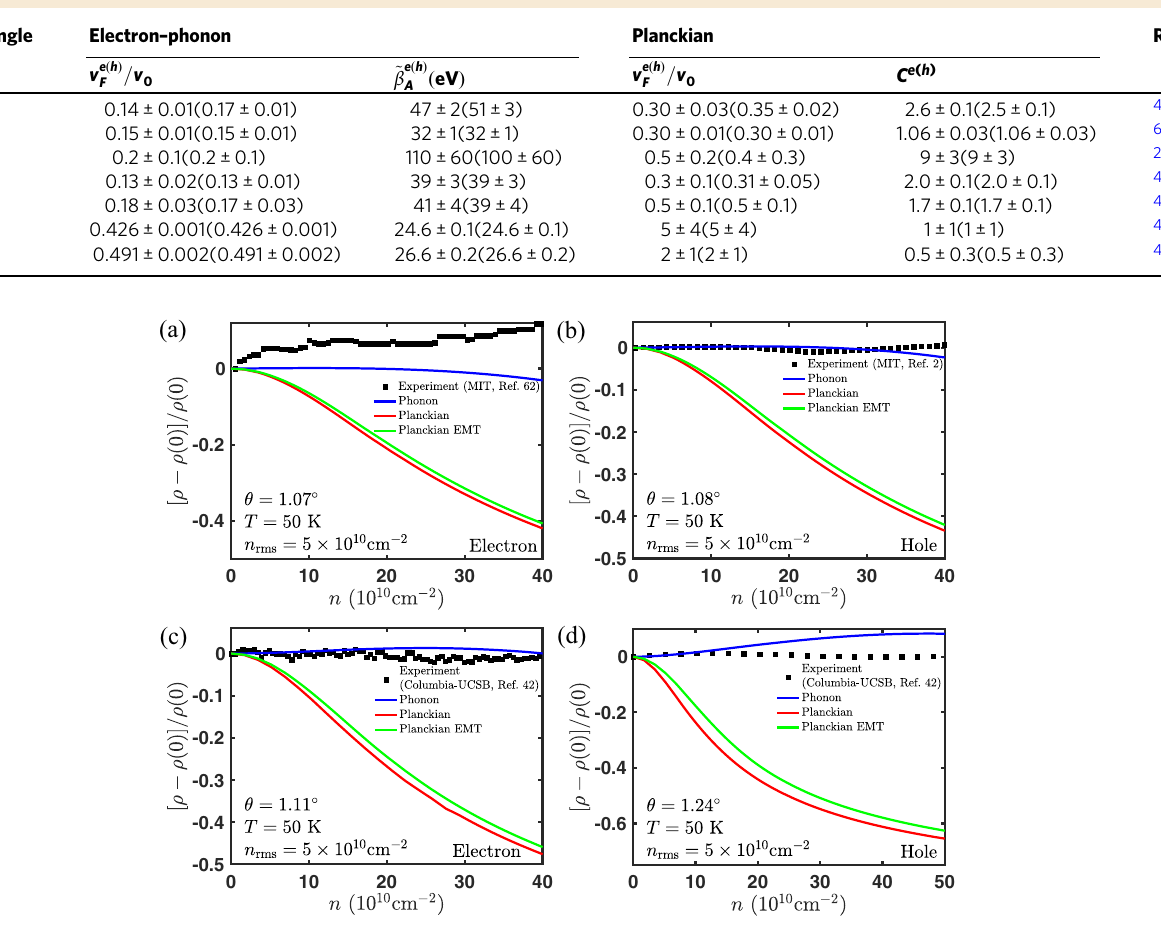
Fig. 8 Alternative method for comparing the phonon theory (blue), Planckian theory (red), and experimental data (black) focusing only on the change in resistivity with carrier density. We take four representative experimental curves from the full data set used to make Fig. 5, i.e., a θ = 1.07 ∘ (ref. 62 ), b θ = 1.08 ∘ (ref. 2 ), c θ = 1.11 ∘ (ref. 42 ), and d θ = 1.24 ∘ (ref. 42 ). Theory curves are the same as before, except we use the best theoretical estimates for β Also included is the Planckian theory with effective medium theory to include the effect of disorder smearing (green). Similar to the conclusions in Fig. 5, this method shows that the phonon theory has better agreement with the